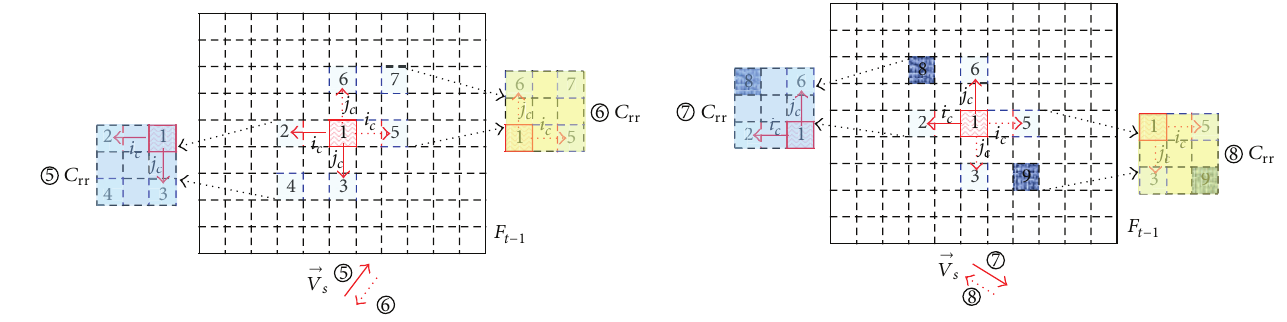
Figure 9: Schematic diagram of 𝐶